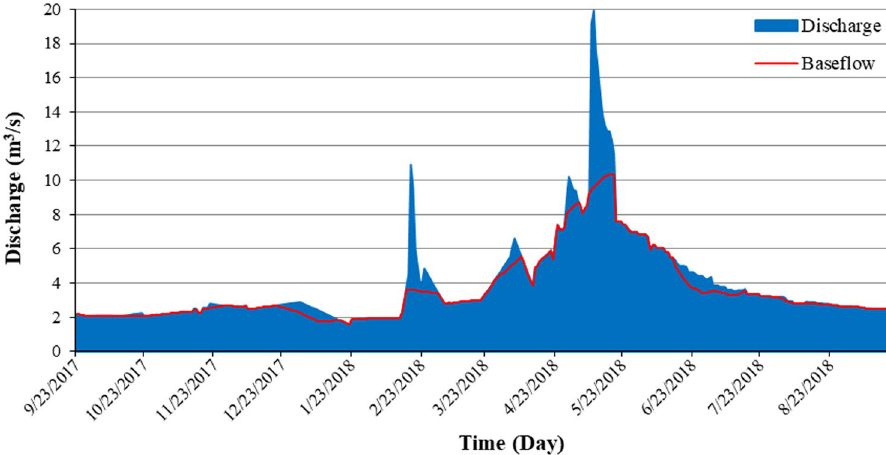
Fig. 4 Baseflow separation of Gamasiyab spring with WT-Db4 wavelet function-at level 6-period of